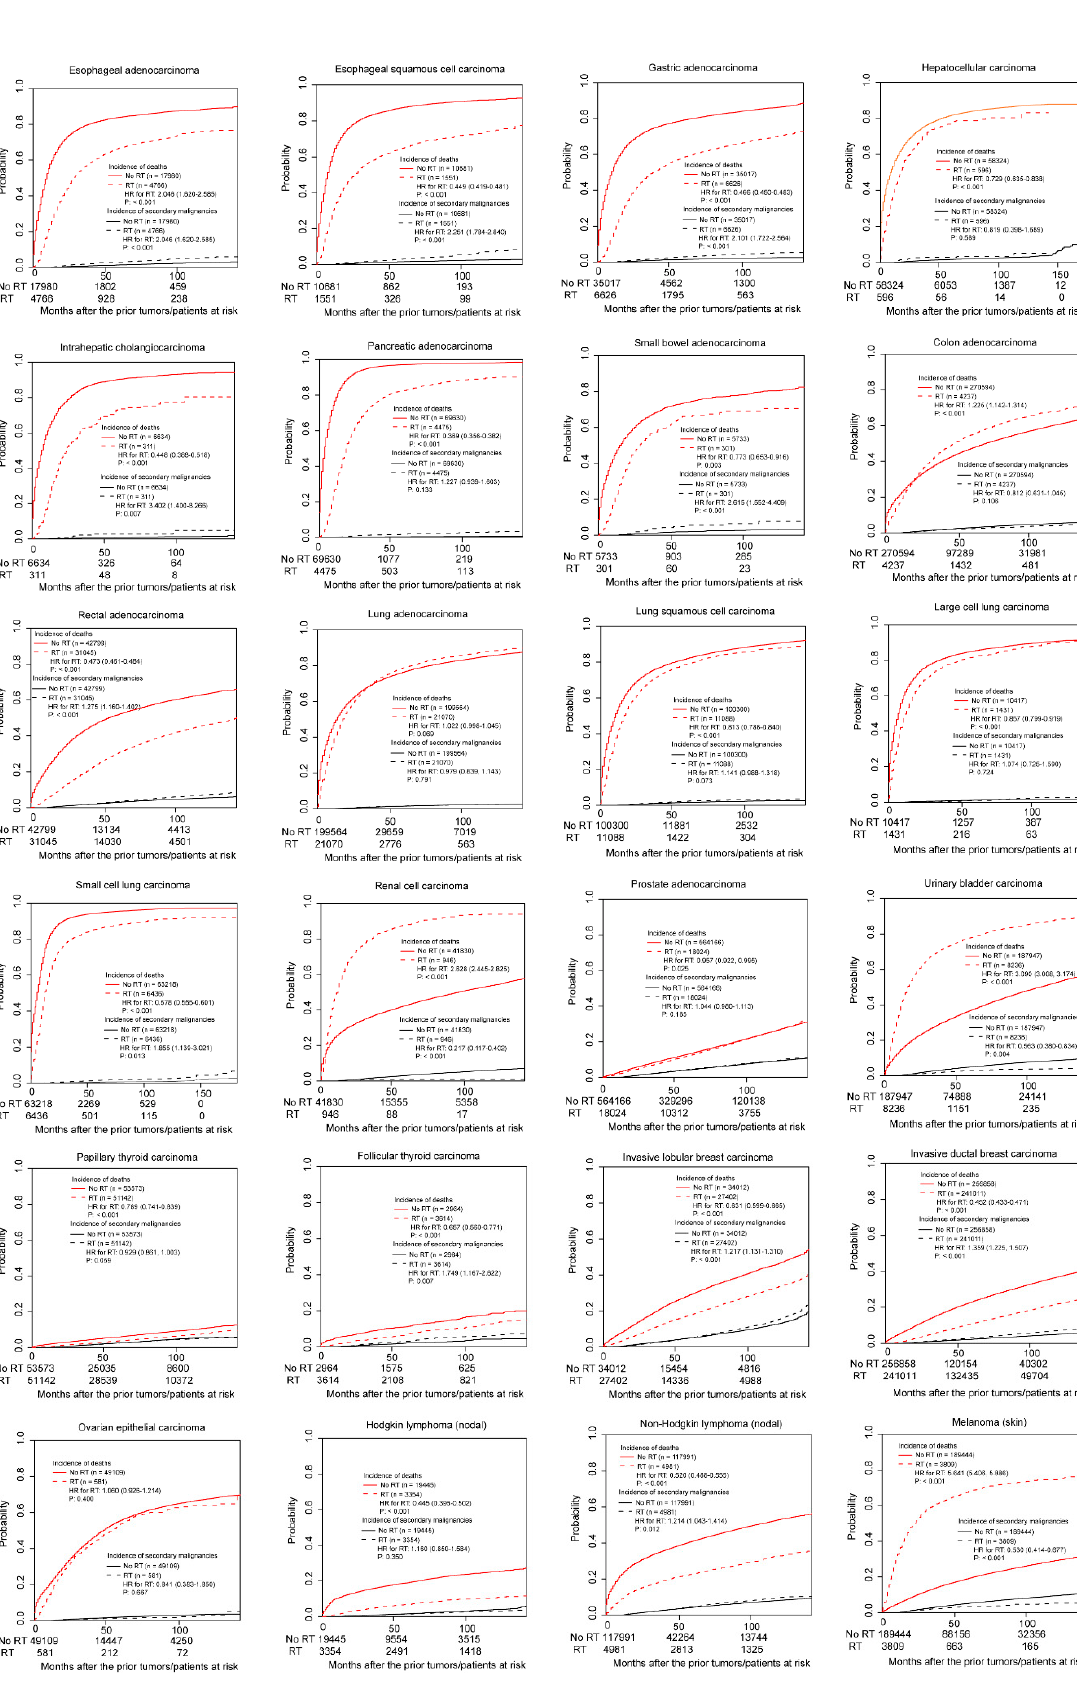
Figure 2. The cumulative incidences of death and secondary primary malignancy in the non-adjusted primary cohorts.